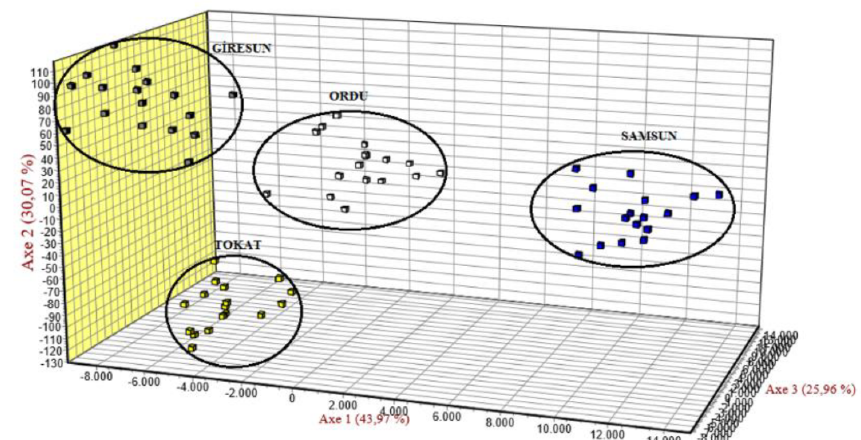
Figure 2. FCA results showing the relationship between the subpopulations.